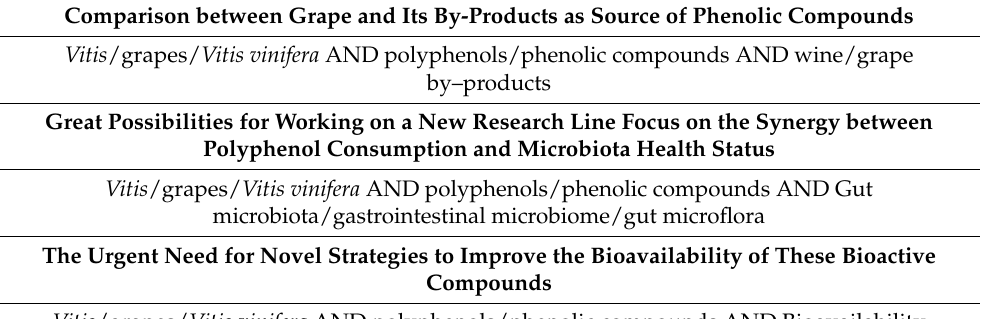
Table 4. Search strategy and equations on grape, grape by-products polyphenols, gut microbiota, and